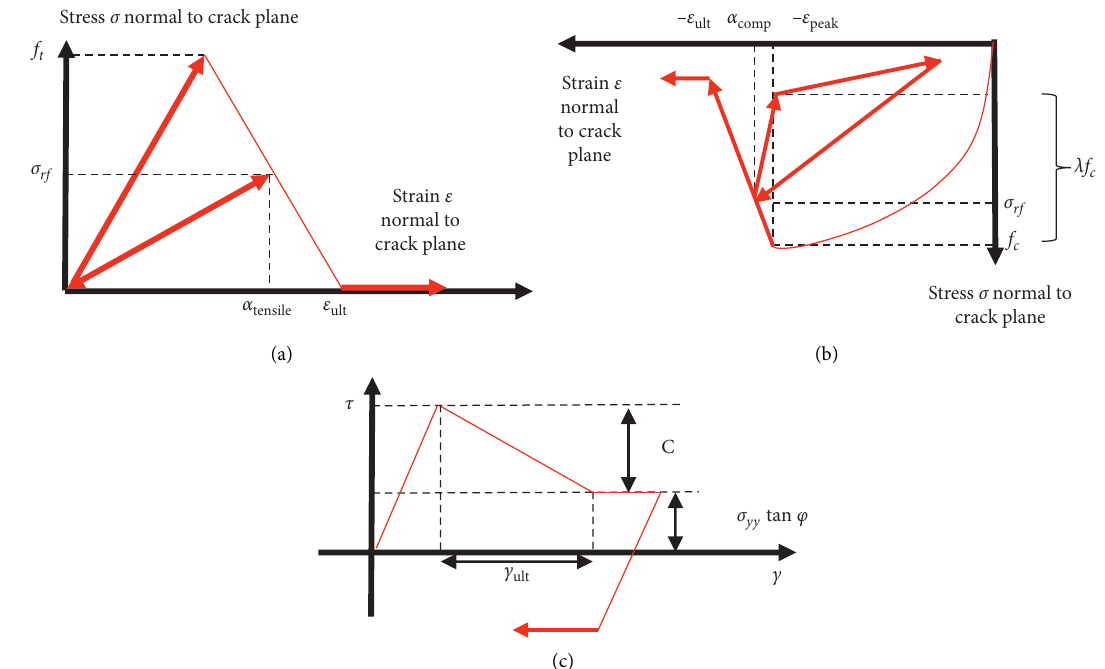
Figure 4: Engineering masonry model (a) behavior in traction, (b) behavior in compression, and (c) shear behavior [69]. Table 1: Material properties of the engineering masonry model. Modulus of elasticity— x -direction (GPa)